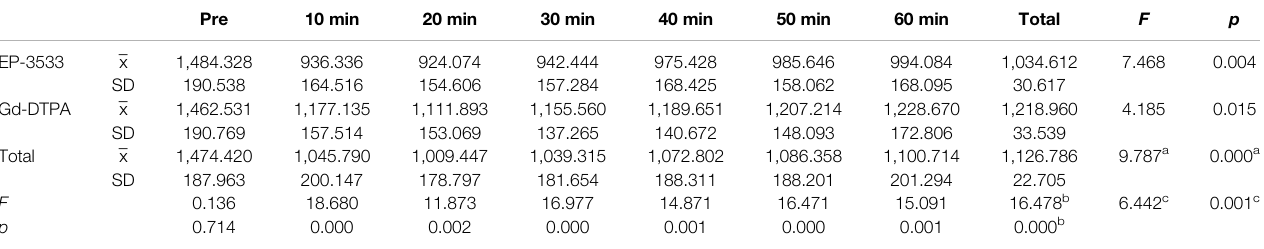
TABLE 1 | T 1 value of the bowel wall before and after molecular probe (EP-3533) and GD-DTPA